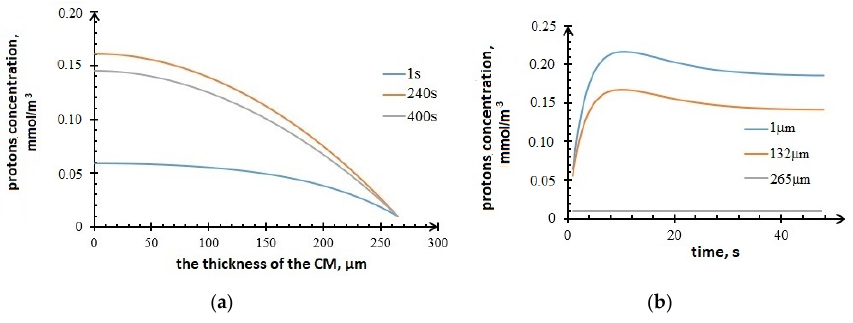
Figure 10. Profiles of protons concentration in the anode, ( a ) vs. CM thickness; ( b ) vs. time.